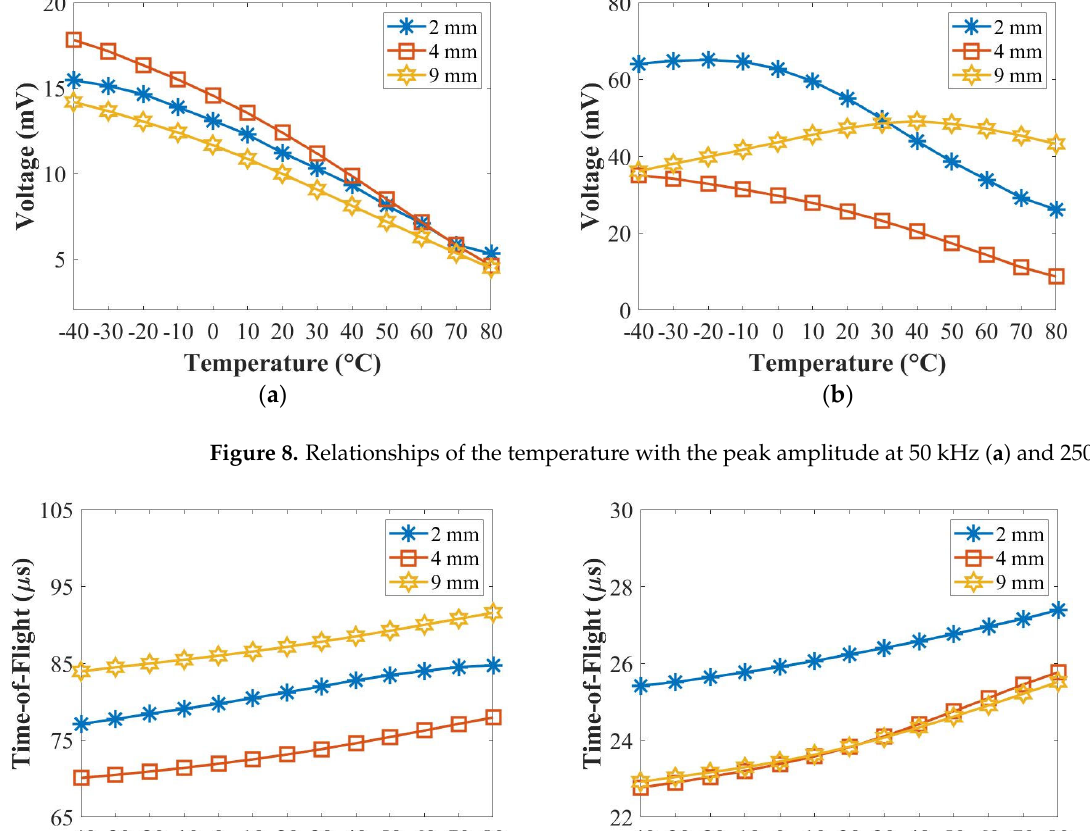
Figure 7. UGWs with peak amplitudes under varying temperatures at 50 kHz ( a ) and 250 kHz ( b ) for the 2 mm thick panel.